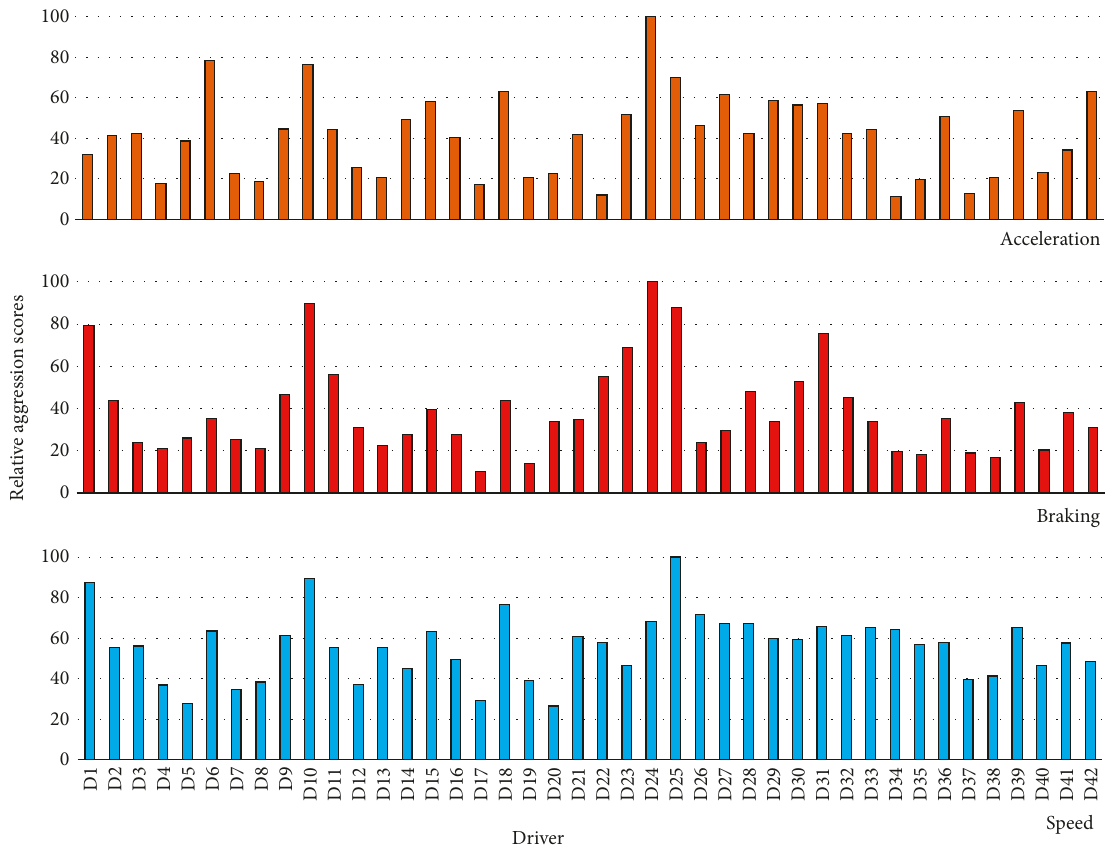
Figure 10: The relative driver aggression in acceleration, braking, and